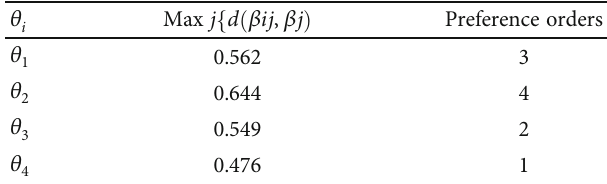
Table 6: Preference orders computed by reference point